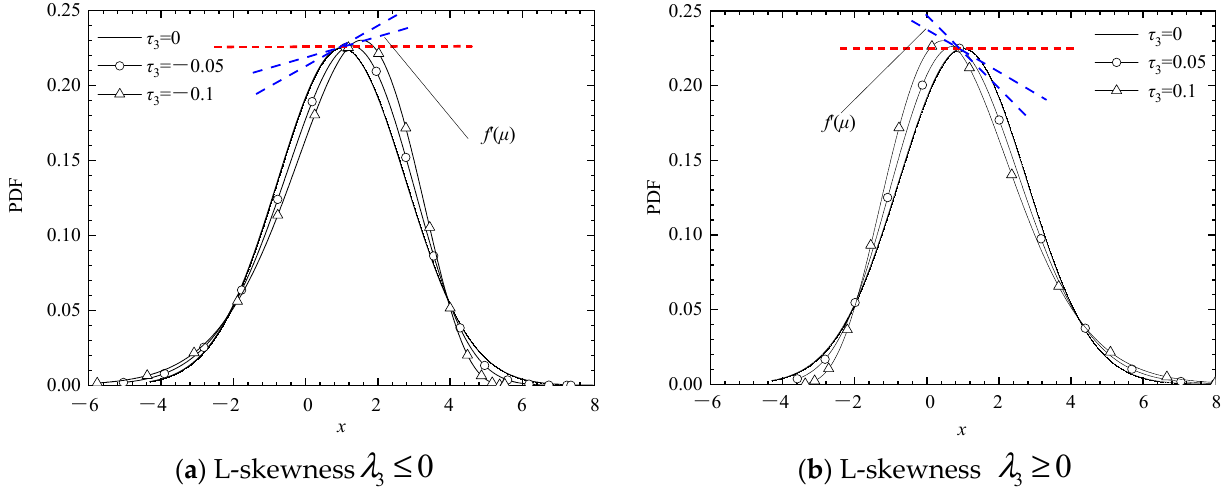
μ ′ λ (cid:48) ( µ ) and λ and . Figure 1. The relationship between the sign of f 3 3